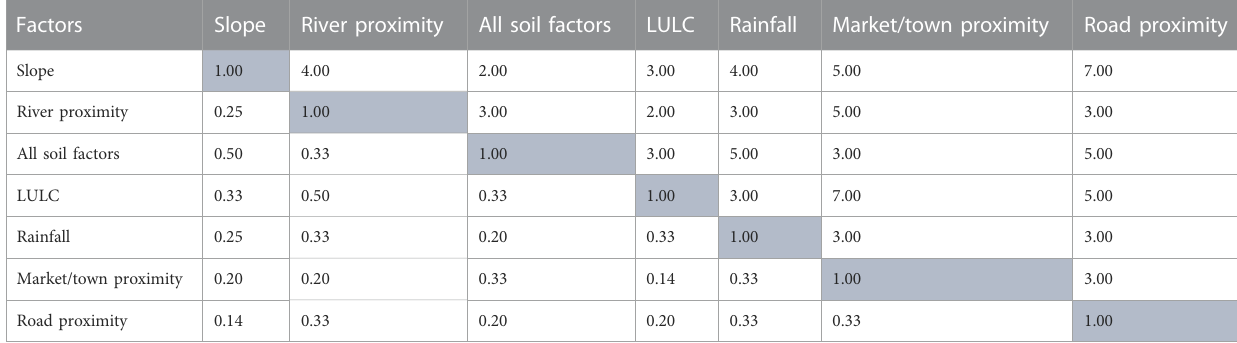
TABLE 10 Pair-wise comparison matrix of all the factors considered to determine the surface irrigation potentials of the Chacha Watershed.